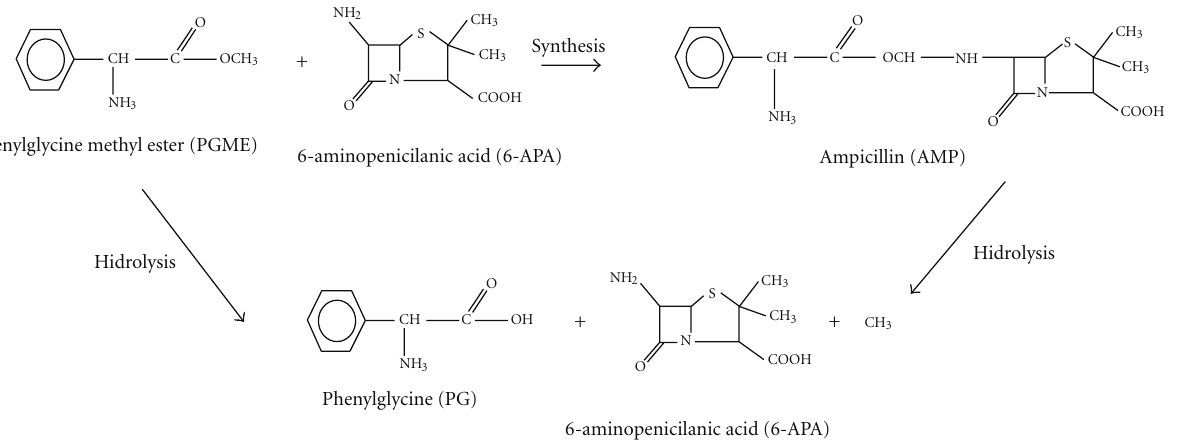
Figure 2: Reactions of enzymatic synthesis of ampicillin [33]. The reaction scheme contains three main reactions: the ampicillin synthesis, the phenylglycine methyl ester hydrolysis, and the ampicillin